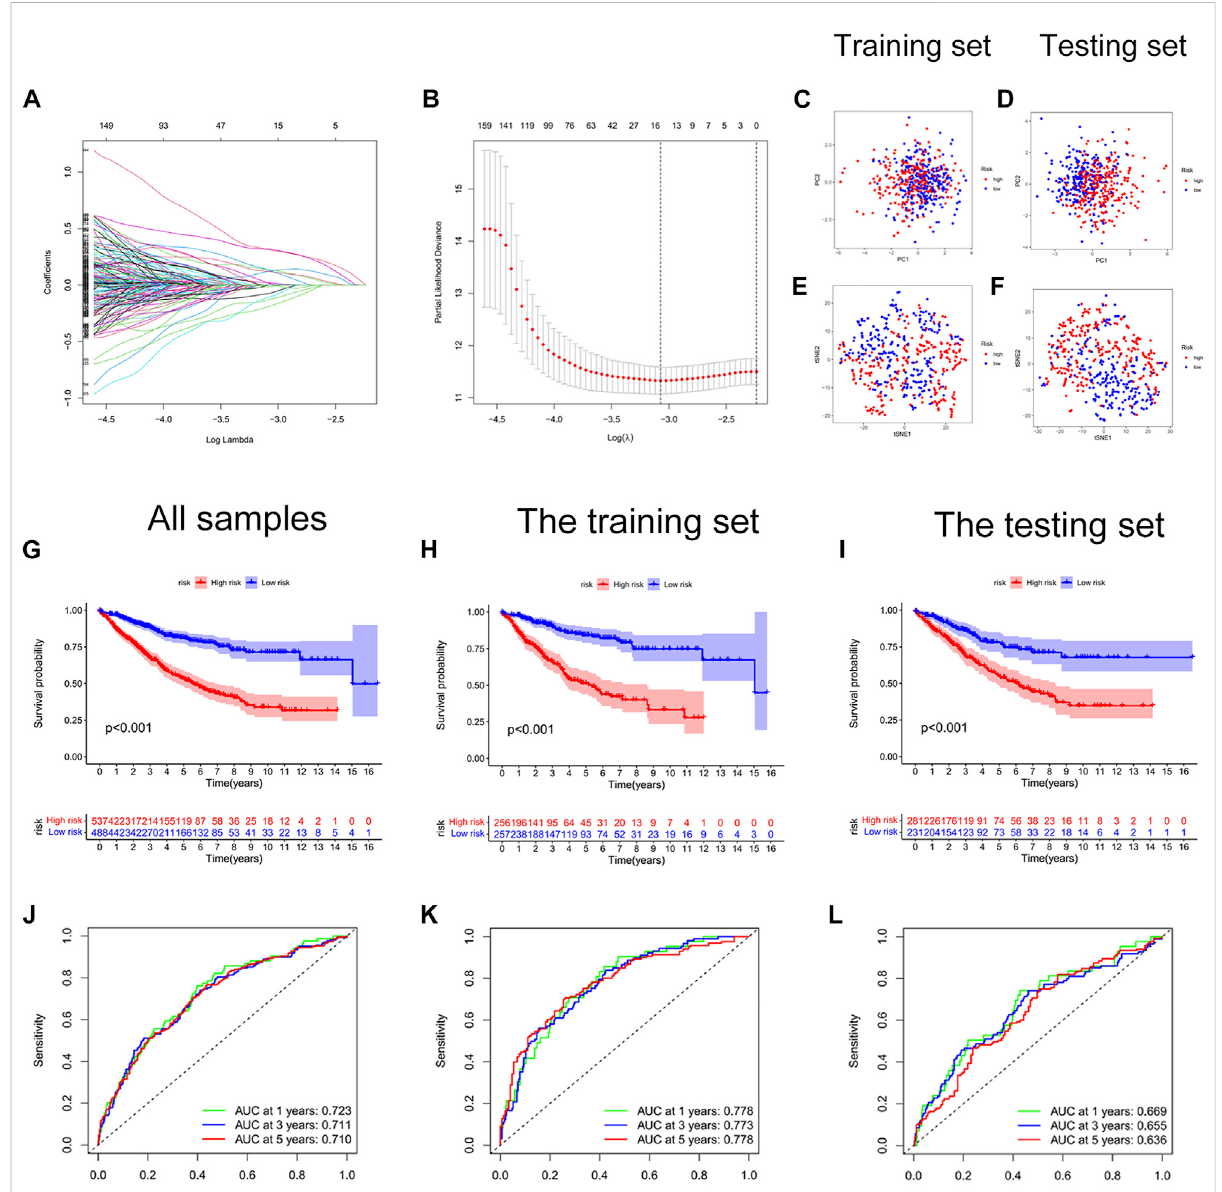
FIGURE 3 Construction of a cellular senescence-related risk score signature. (A) LASSO regression analysis. (B) Cross-validation for tuning the parameter selection. (C) The PCA plot of the training set. (D) The PCA plot of the test set. (E) The t-SEN plot of the training set. (F) The t-SEN plot of the testing set. (G) The K-M survival curve of all colon cancer samples, p < 0.001. (H) The K-M survival curve of the training set, p < 0.001. (I) The Kaplan-Meier survival curve of the testing set, p < 0.001. (J) The AUC values of 1-year, 3-years, and 5-years survival for all colon cancer patients were more than 0.700. (K) The AUC values of 1-year, 3-years, and 5-years survival for the training set were more than 0.750. (L) The AUC values of 1-year, 3- years, and 5-years survival for the testing set were more than